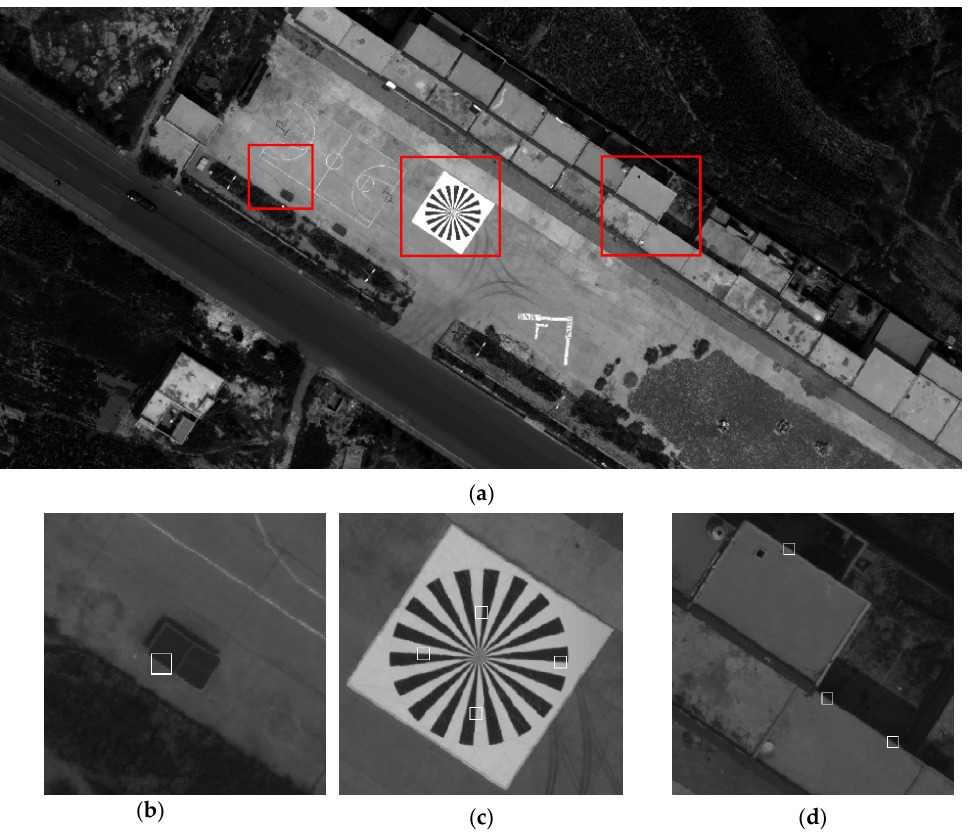
Figure 8. ( a ) Measurement area; ( b ); ( c ); and ( d ) are some examples of extracted knife-edge areas.